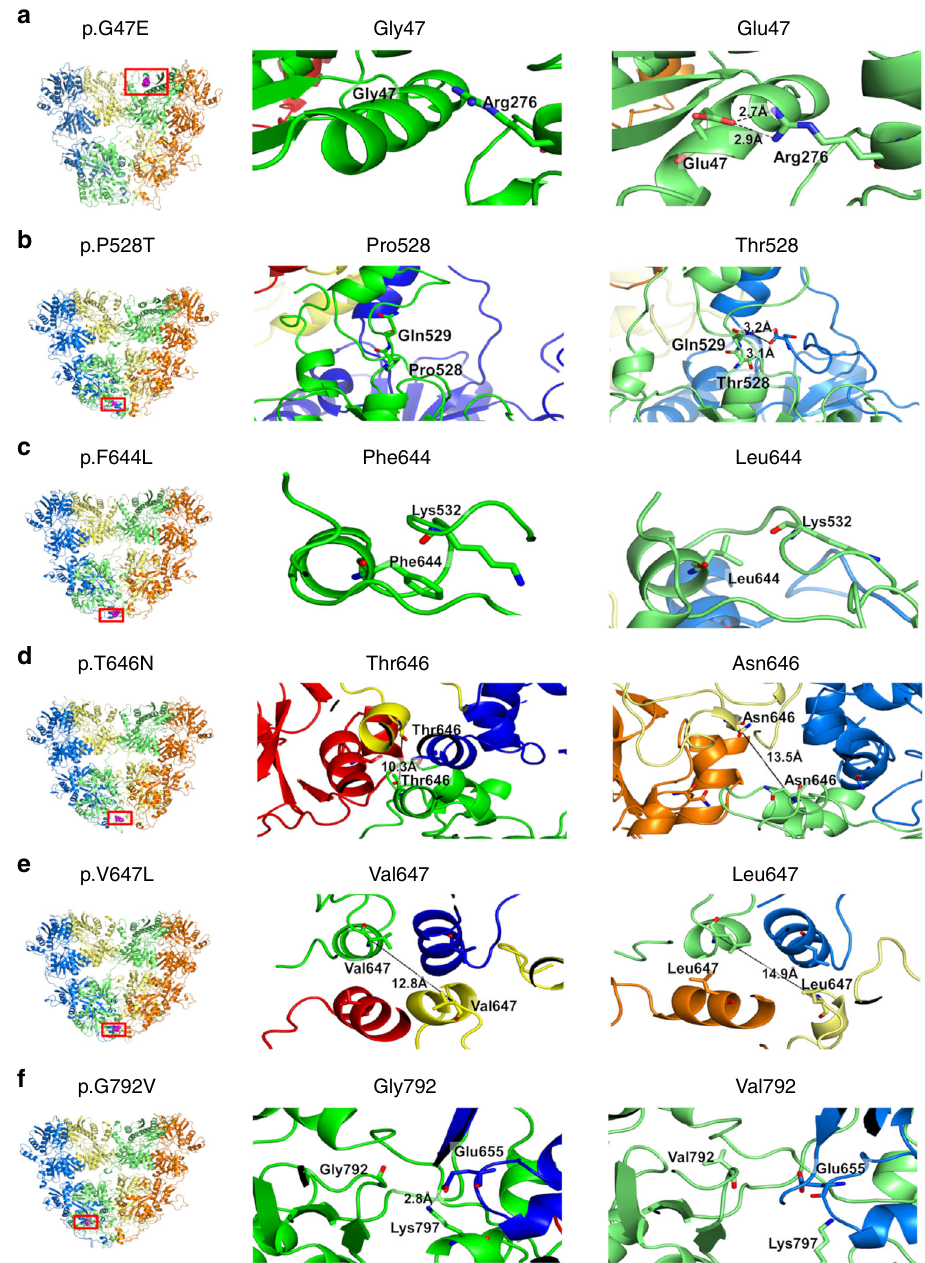
Fig. 3 Molecular modeling and predicted consequences of 6 GRIA2 de-novo missense variants Left panel: Six modeled GRIA2 de-novo missense variants (highlighted in purple within red rectangle) affecting the amino-terminal domain (ATD) and ligand-binding domain (LBD) of GluA2; Middle panel: particular of the wild-type GlUA2 residue; Right panel: particular of the mutated GluA2 residue. a For variant p.G47E, the presence of the glutamic acid residue (right panel) in place of the glycine residue (middle panel) is predicted to cause the formation of two hydrogen bonds with a neighboring arginine residue; hydrogen bond distances are shown for the mutant structure. b The presence of a Threonine residue in position 528 (right panel) is predicted to cause a slight change in the backbone conformation of the neighboring residues that, in turn, allows hydrogen bonding formation between the two chains forming the LBD domain. c Mutation p.F644L causes the loss of hydrophobic interactions between residue 644 and the side chain of Lys532. d For mutation p. T646N, the presence of a more hydrophilic Asparagine residue increases the distance between the distal chains by about 3 Å, at the interface of LBD and TMD (right panel). e For mutation p.V647L, increased hydrophobicity of Leucine (right panel) compared to Valine (middle panel) increases the separation of helices at the interface between LBD and TMD by about 2 Å. f For variant p.G792V, the presence of a more hydrophobic Valine residue in close proximity to the binding site is predicted to cause a sliding movement with respect to the neighboring chain, disrupting the interchain salt bridge between Glu655 and Lys797; hydrogen bond distance is shown in the wild-type GluA2 (middle